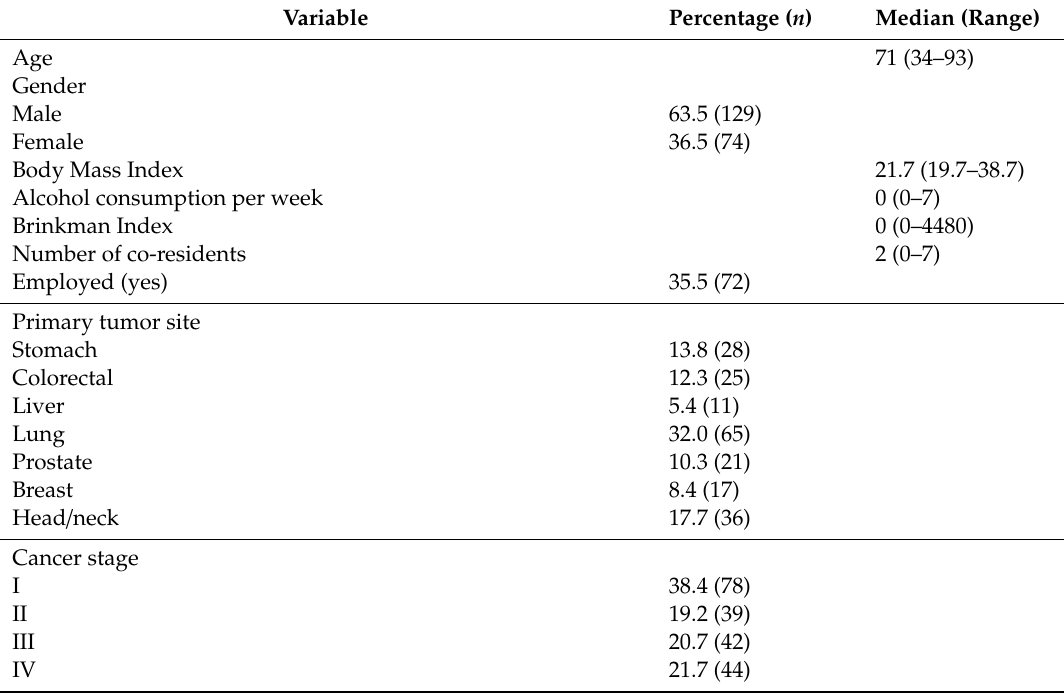
Table 2. Participants’ characteristics ( n =